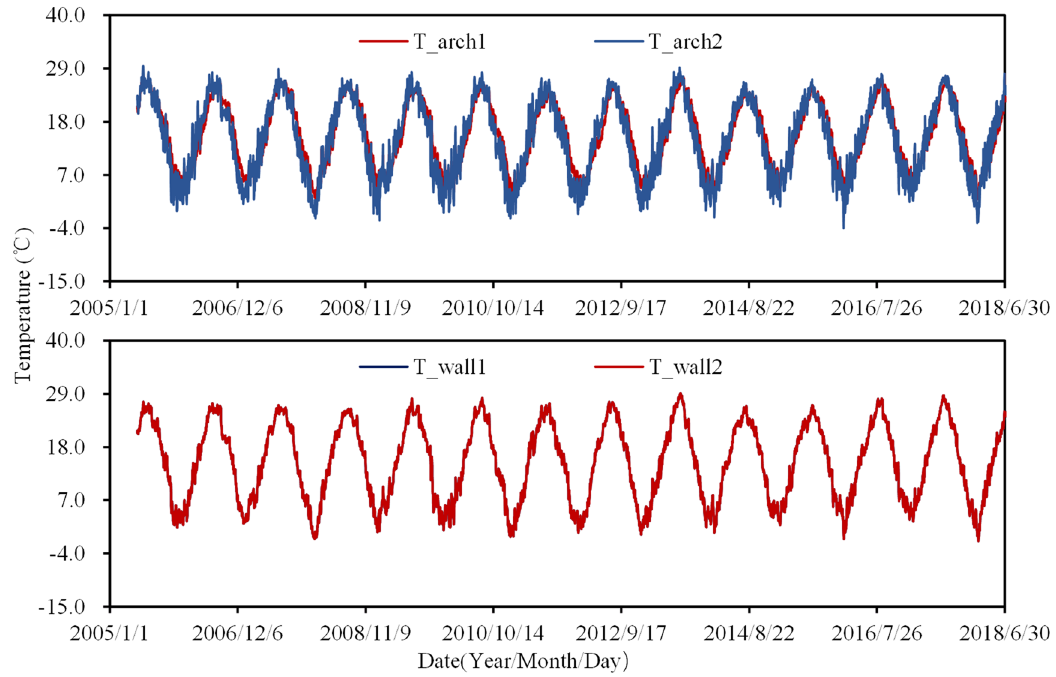
Figure 7. Measured temperature inside and outside the insulation layer.